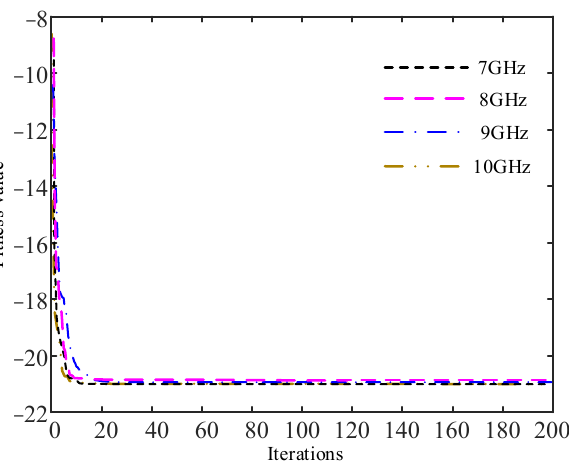
Figure 7. Convergence curves verses iterations at four different frequencies for low PSLL beampattern synthesis.